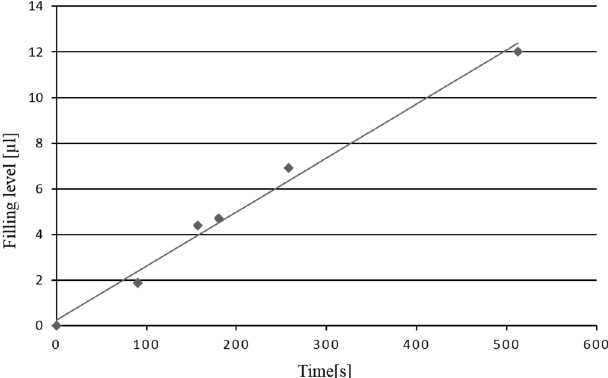
Figure 8. Evaluation of the microfluidic filling level. The data show the propagation of the soil solution over the 12 mm channel. The volume was calculated by analyzing the microscope images.